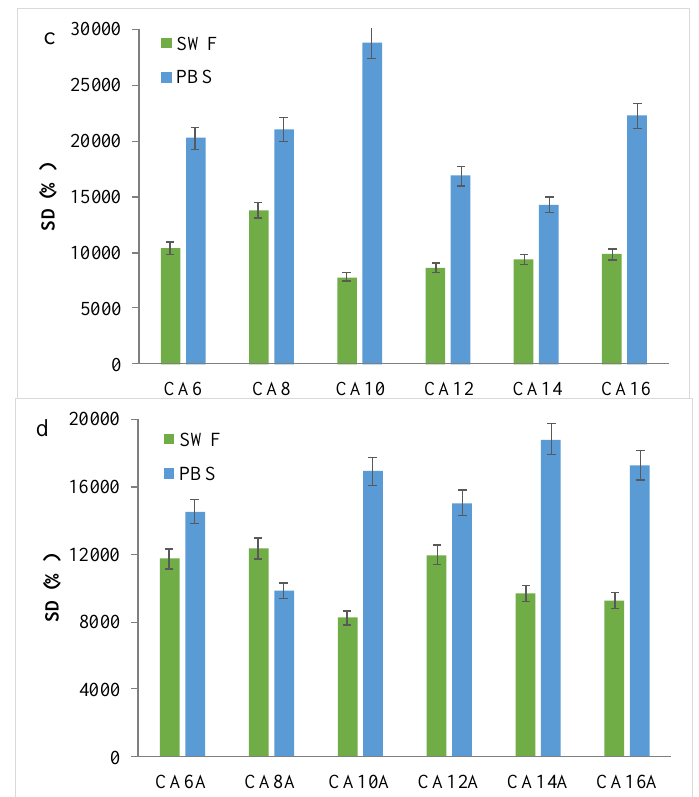
Figure 5. Swelling behavior of the hydrogels: ( a , b ) Kinetic swelling degree data, in PBS for hydrogels with acrylic and methacrylic acid; ( c , d ) Maximum swelling degrees in PBS or SWF, before and after arginine coupling.